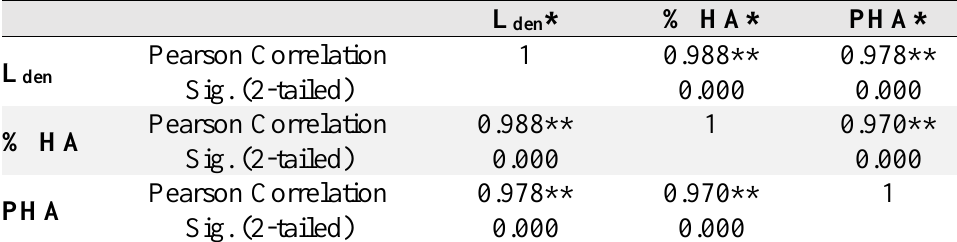
Table 5. Correlations (% HA vs.